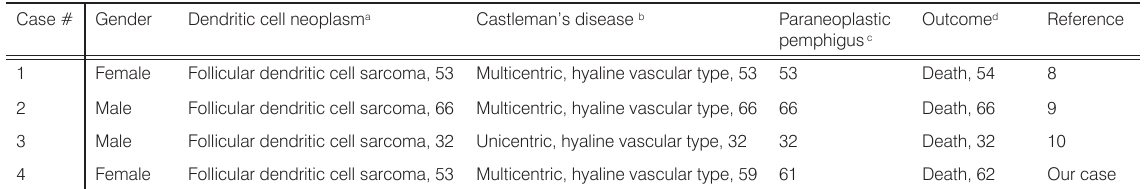
Table 1. Characteristics of the patients with the triple association Castleman’s disease, dendritic cell neoplasm, and paraneoplastic pemphigus described in the literature. Case # Gender Dendritic cell neoplasm